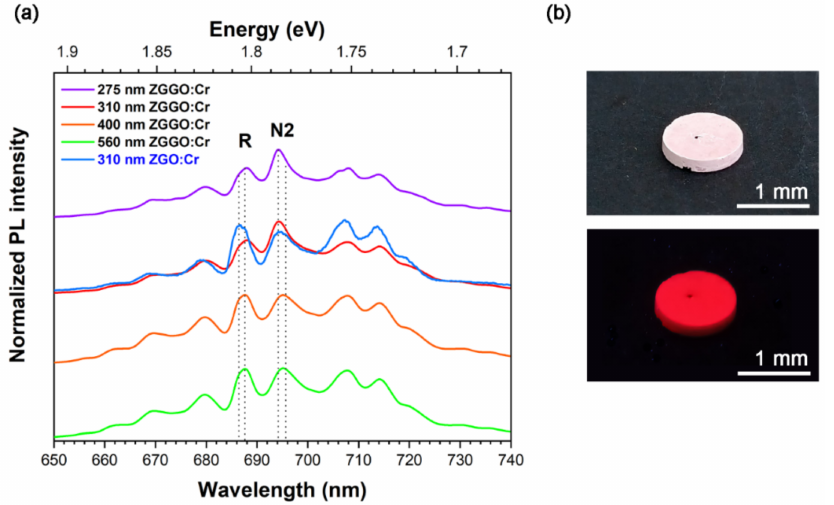
Figure 5. ( a ) RT PL spectra of ZGO:Cr and ZGGO:Cr obtained under different excitation wavelengths: onset of the band-to-band absorption (275 nm), defect absorption band (310 nm), and intraionic 4 A 4 T → 4 T 2 2 absorption bands (400 nm and 560 nm, respectively). Besides the R- and N2-lines, 1 , the spectra are dominated by Stokes and anti-Stokes phonon sidebands for longer and shorter wavelengths. The spectra were vertically shifted for clarity. ( b ) Photograph of the ZGGO:Cr pellet under white light ( top ) and 256 nm lamp ( bottom )